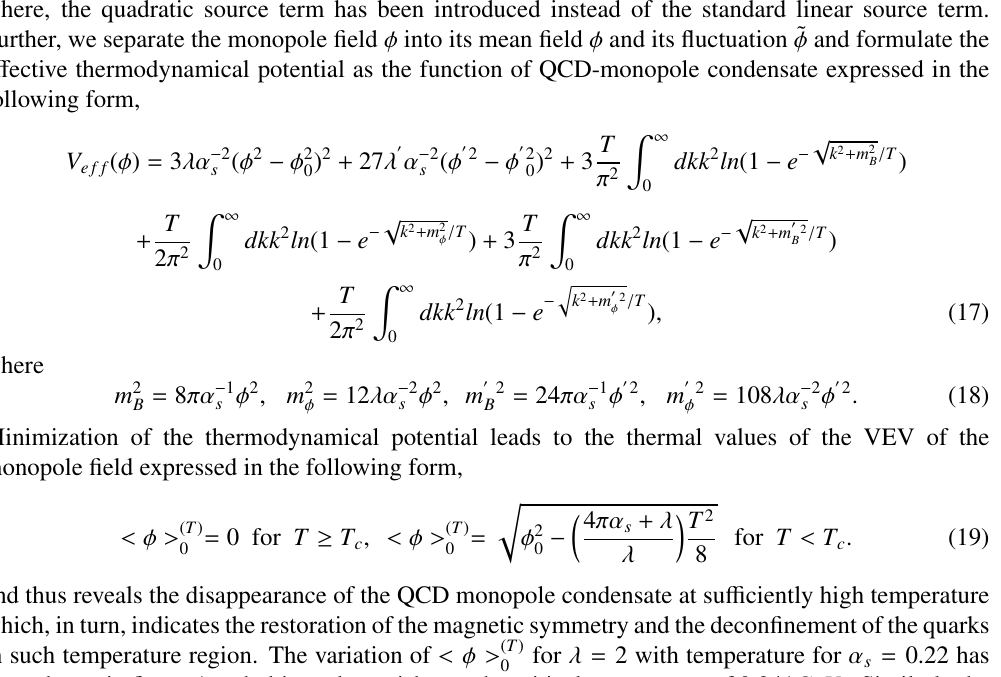
) with temperature ( T ) and (b) 0